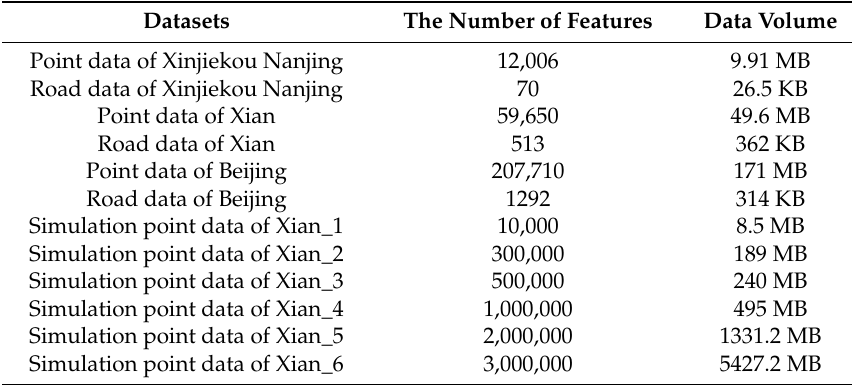
Table 2. Measured data and simulation data for the experiment in this study.